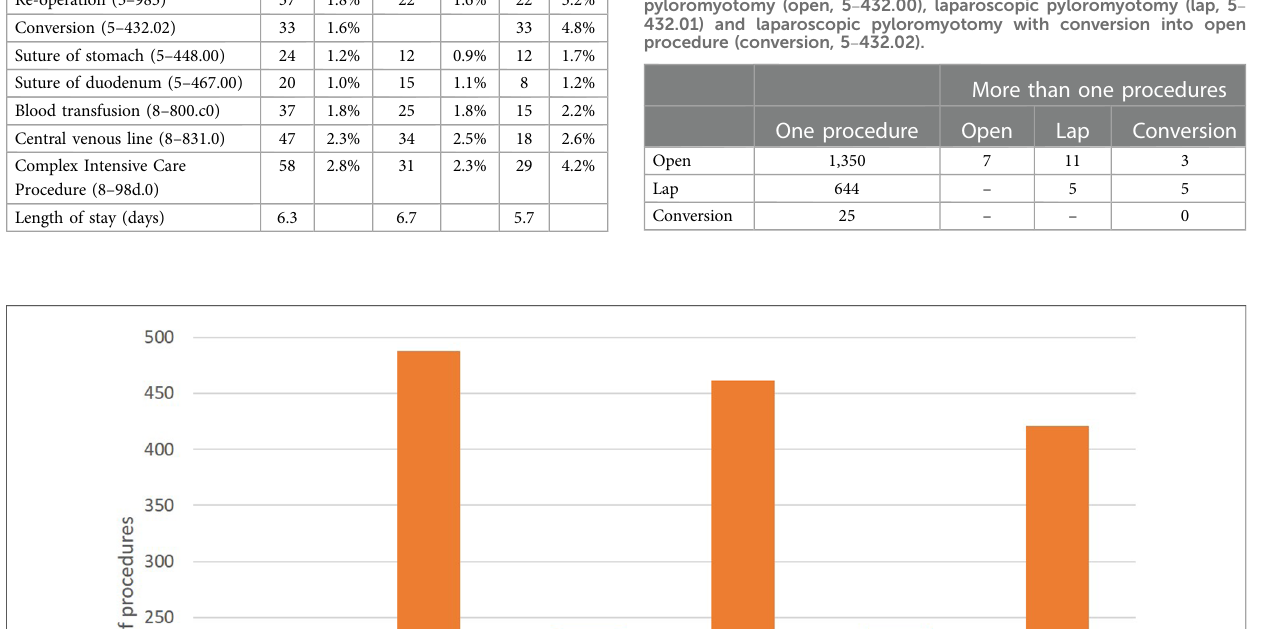
TABLE 2 Number of patients with different procedures documented, open pyloromyotomy (open, 5 – 432.00), laparoscopic pyloromyotomy (lap, 5